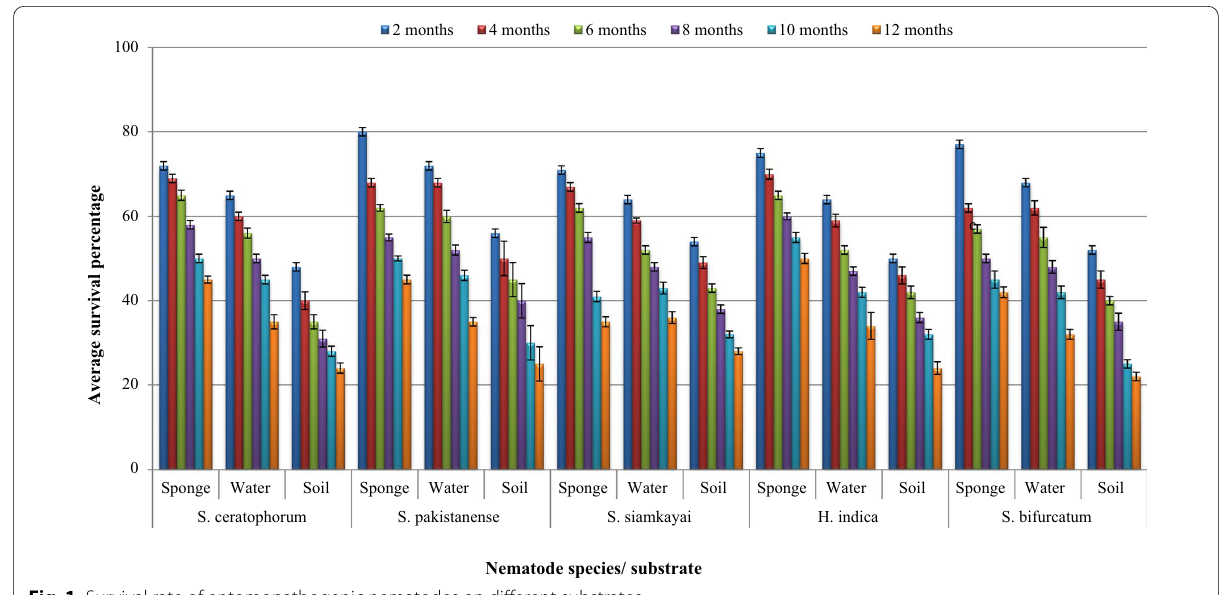
Fig. 1 Survival rate of entomopathogenic nematodes on different